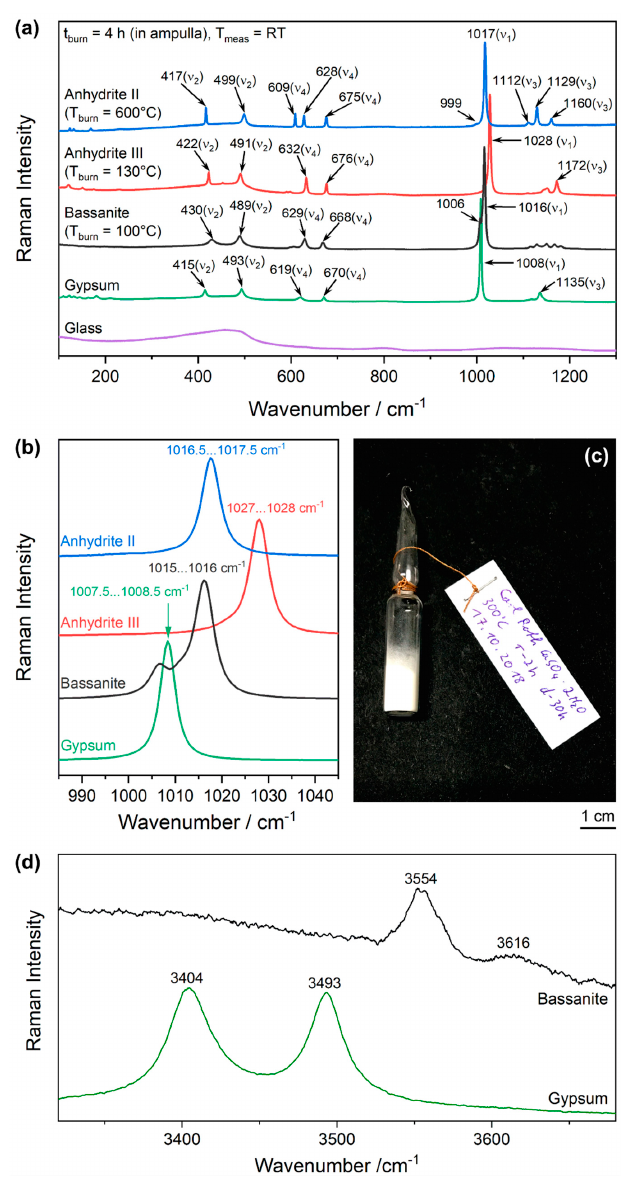
Figure 2. ( a ) Raman spectra of the four phases of the CaSO 4 –H 2 O system is stable at room temperature. ( b ) Excerpt showing the most prominent modes and their typical wavenumber ranges. ( c ) Glass ampulla with burnt gypsum powder. ( d ) Raman bands of crystal water in gypsum and bassanite.